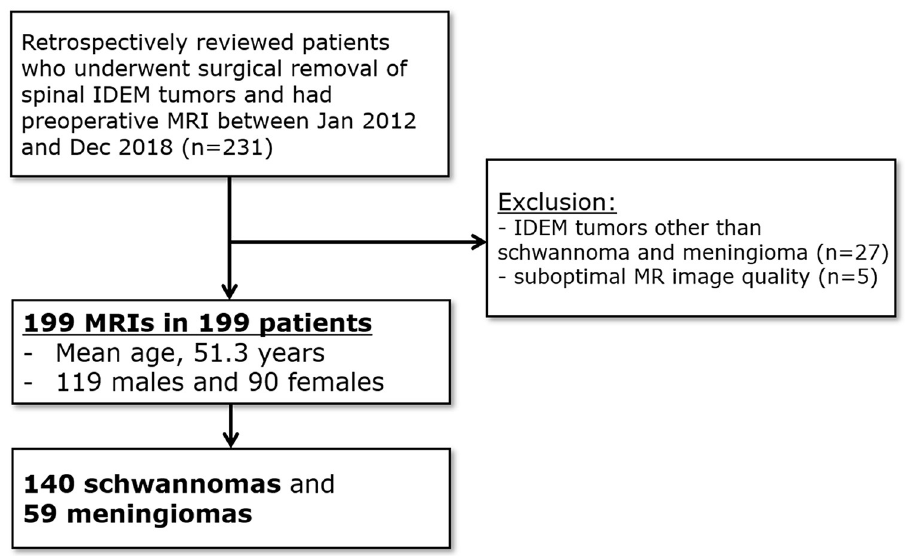
Fig 1. Patient flow diagram. IDEM, intradural